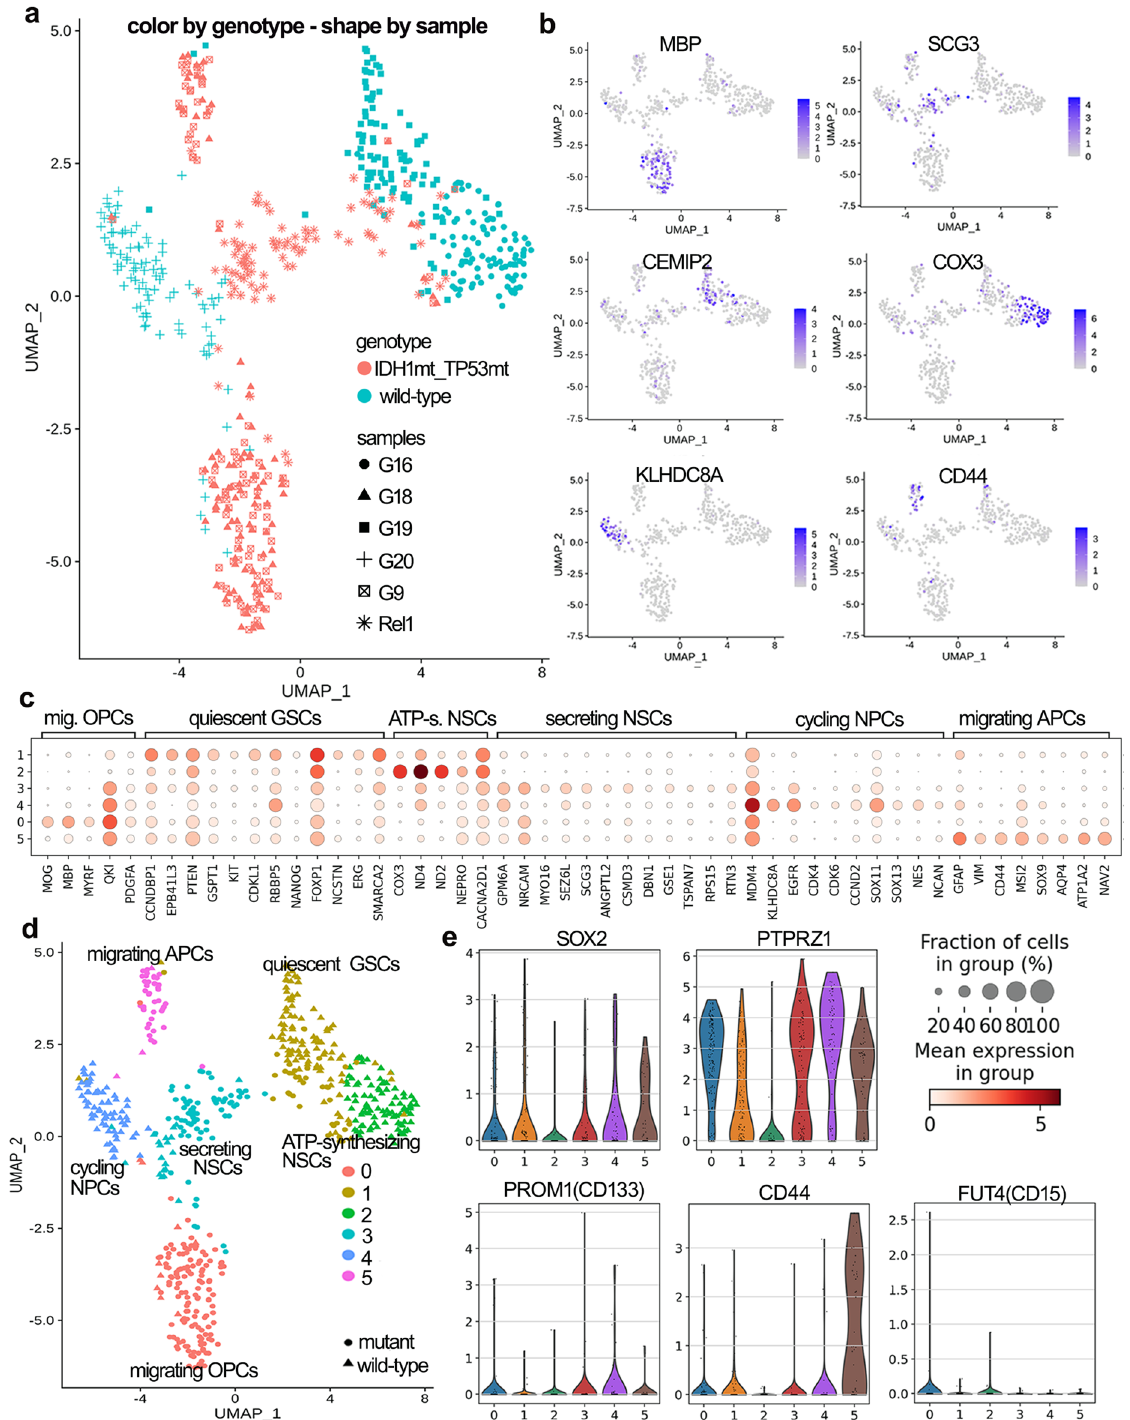
Figure 2. Cell cluster annotation. ( A ) UMAP plot showing the clustering of GSCs colored by genotype and shaped by glioma sample. ( B ) Expression of characteristic cluster-specifying genes overlaid on the 2D-UMAP space. ( C ) Stack circle plot showing expression of genes characterizing 6 UMAP clusters named “migrating OPCs” (mig. OPCs), “quiescent GSCs”, “ATP-synthesizing NSCs” (ATP-s. NSCs), “secreting NSCs”, “cycling NPCs”, “migrating APCs”. ( D ) UMAP clusters colored by clusters and shaped by genotype with annotated cell types. ( E ) Violin plots highlighting the expression of the selected stem cell genes (SOX2, PTPRZ1, PROM1, CD44, FUT4) for UMAP